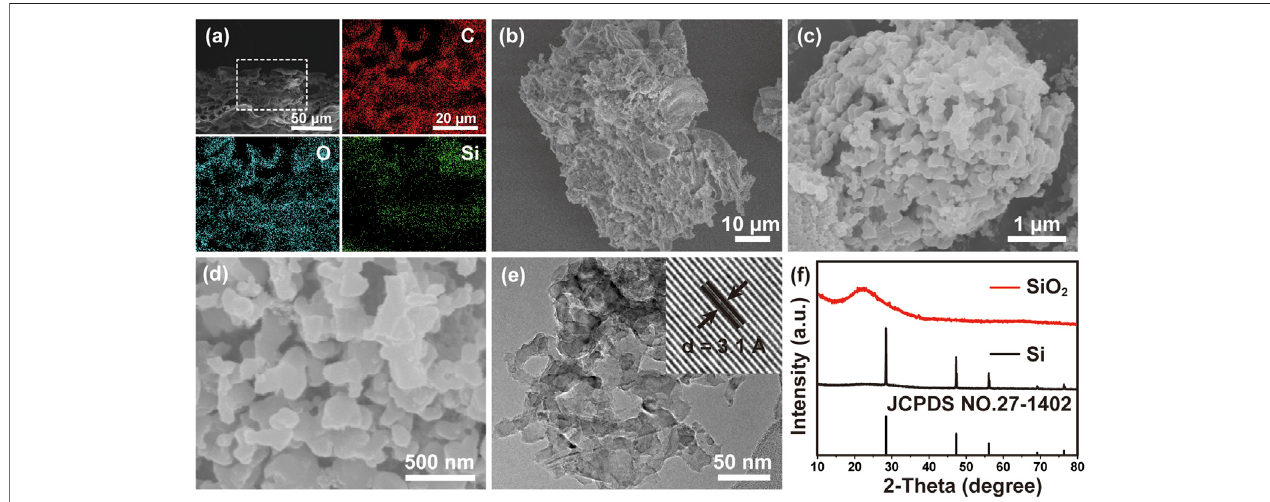
FIGURE 2 | (A) HRTEM image of macroporous Si@C composites. (B) Raman spectrum of macroporous Si@C composites. (C) TGA curve of macroporous Si@C composites.